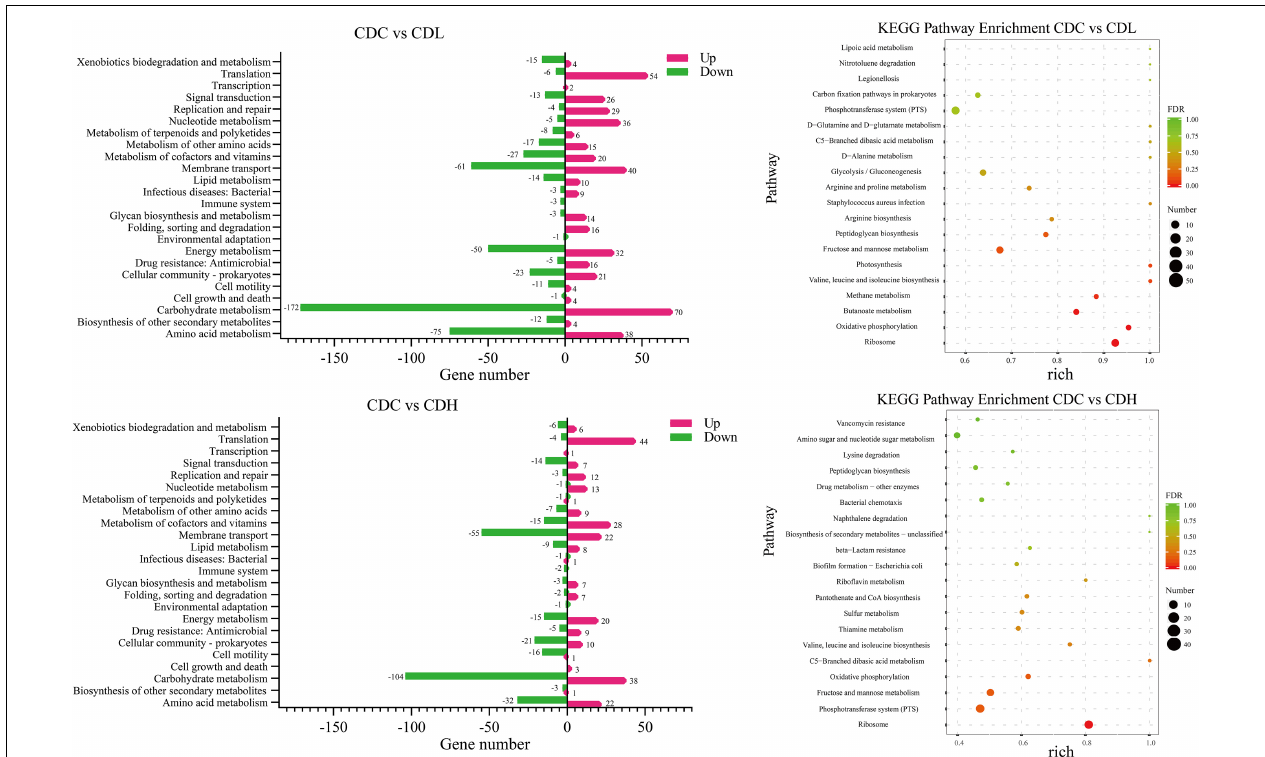
FIGURE 7 | KEGG pathway analysis of the C. difficile DEGs in different groups. Rich (Rich factor) represent the ratio of the DEGs in the pathway to their annotated DEGs. The larger of the rich factor, the greater of enrichment degree. The size and color of solid circle, respectively, represent the number of differential genes enriched in this pathway and their FDR values. The range of FDR values is 0 to 1. The closer to zero value represents the enrichment is more significant.